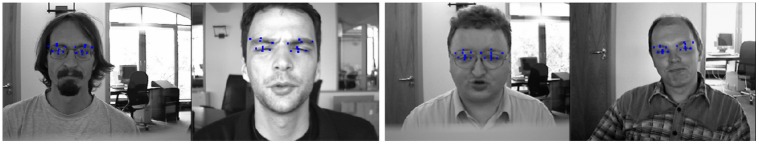
Facial alignment using random ferns.Explicit shape regression facial alignment approach applied to challenging eye detection cases. Occlusion due to various features and expression variations are examined. Reasonable detection results are obtained in some partially occluded cases (e.g., (a) and (c)), while accurate results are obtained for completely occluded cases, e.g., (b).